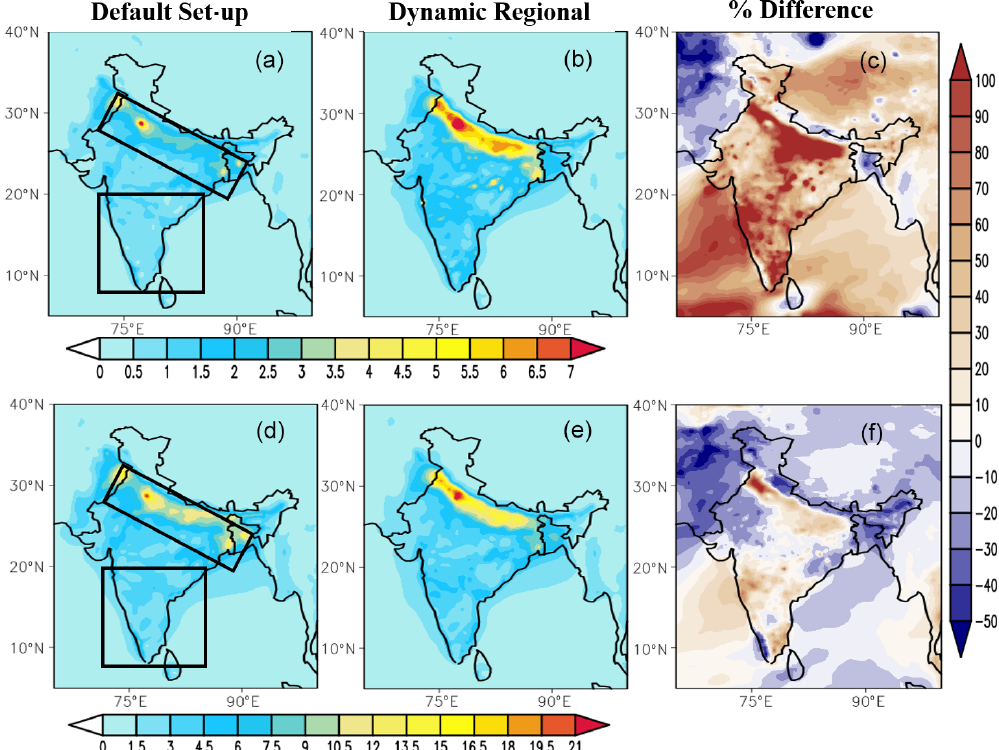
Figure 1. Spatial distribution of surface mass concentration (µgm − 3 ) of BC (a, b) and OC (d, e) in 2010 over the Indian subcontinent using (a, d) the default and (b, e) the augmented model configurations. Panels (c) and (f) represent the corresponding percentage differences due to the augmented model set-up (positive values imply an increase in mass concentration). The vertical distributions (shown in Fig. 4) are analysed for the IGP and PI subregions marked by boxes panels (a) and (d) .